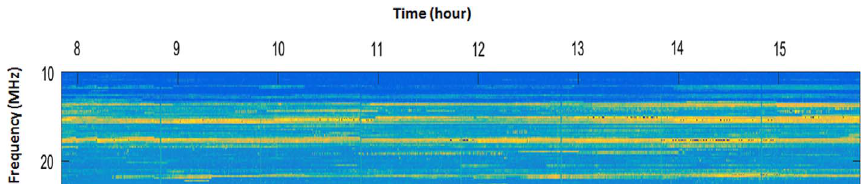
Fig. 7. Example of the RFI spectrum (yellow part) on a Time-Frequency dynamic